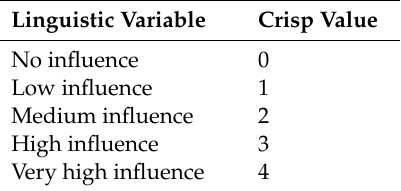
Table 3. DEMATEL’s evaluation